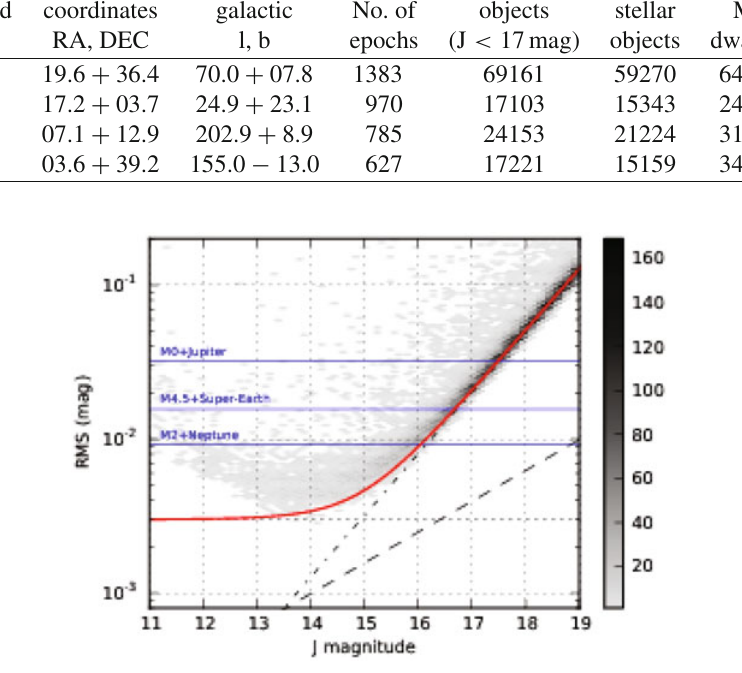
Figure 1. RMS diagram of the 19hr field, with expected signal depths. The red solid line is our noise model consisting of Poisson noise, sky noise and systematic noise.